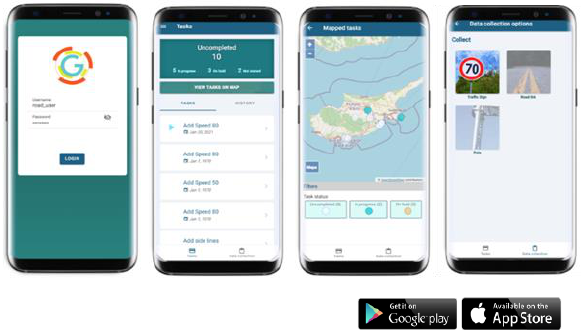
Figure 7. Mobile application User Interface